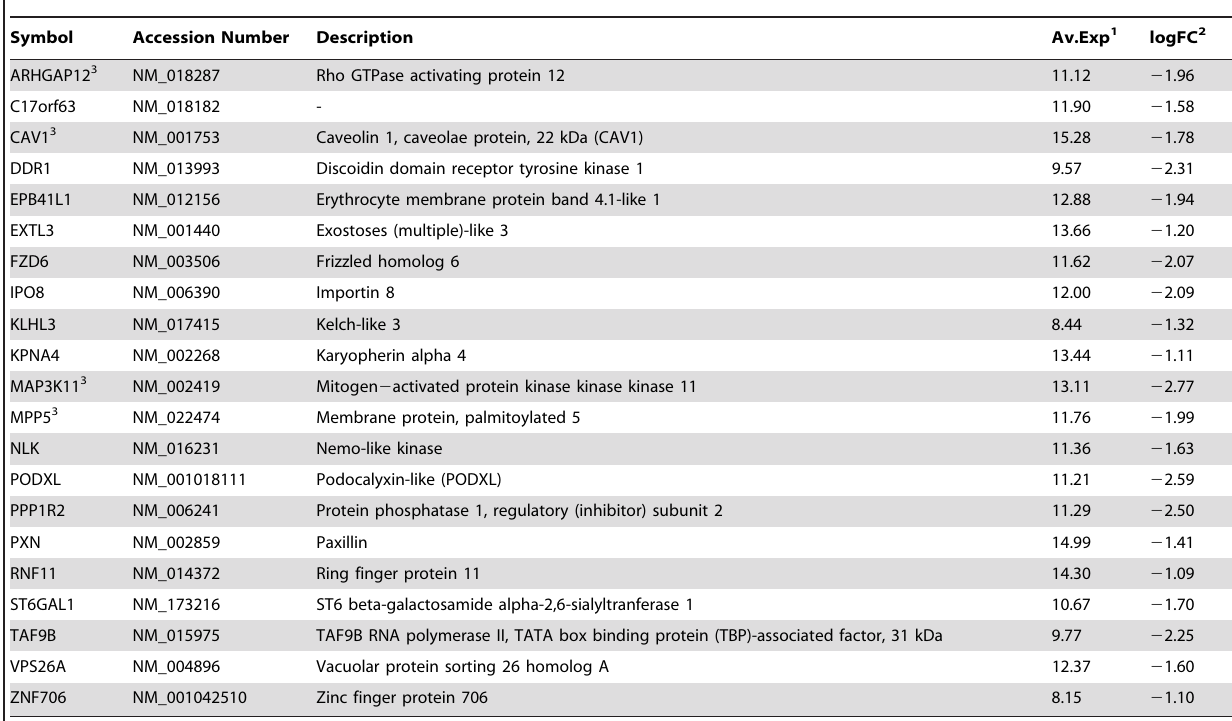
Table 1. List of the main miR-199a-5p predicted targets significantly downregulated following miR-199-5p overexpression